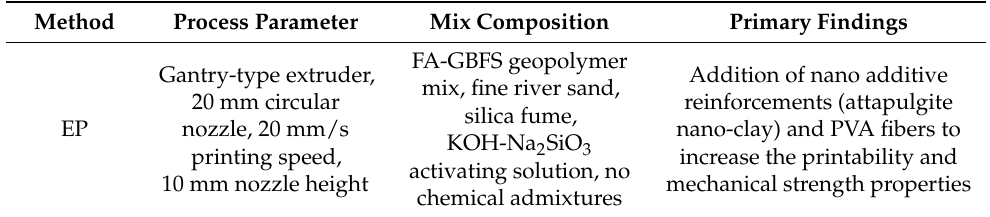
Table 5. Details of [88] research work.